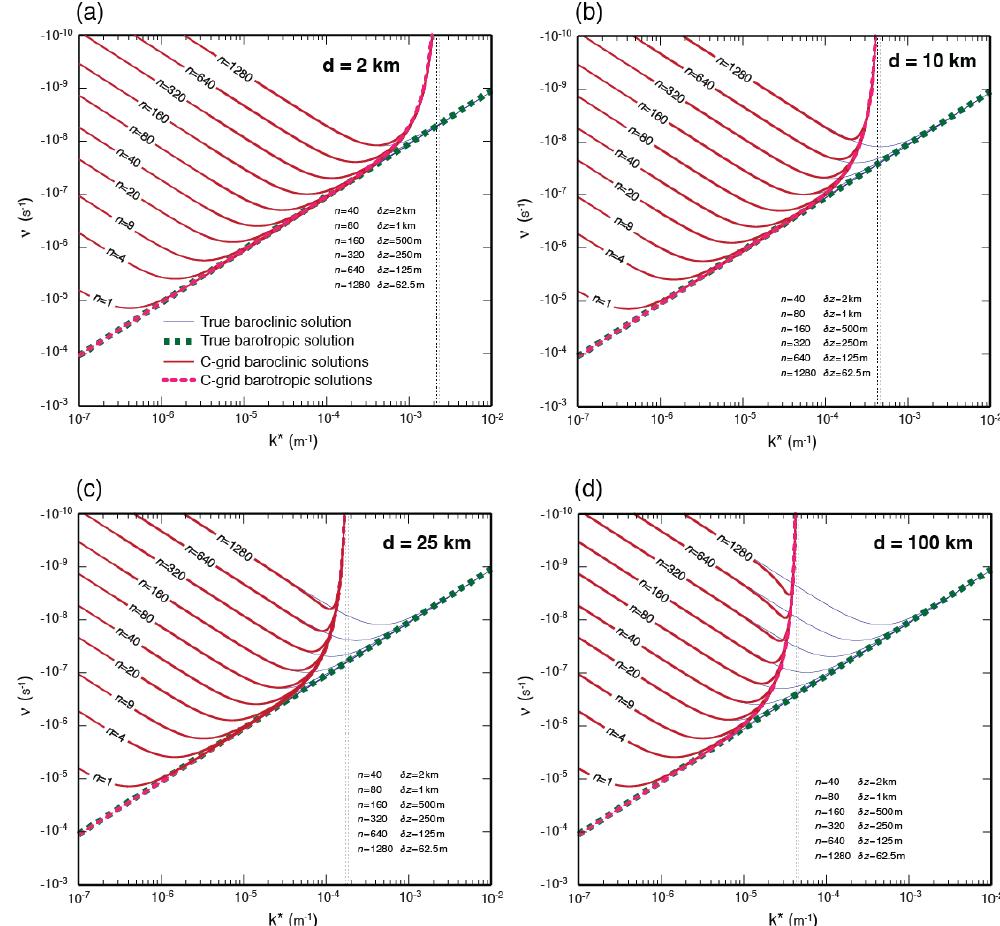
Figure 2. Same as Fig. 1 but on the C